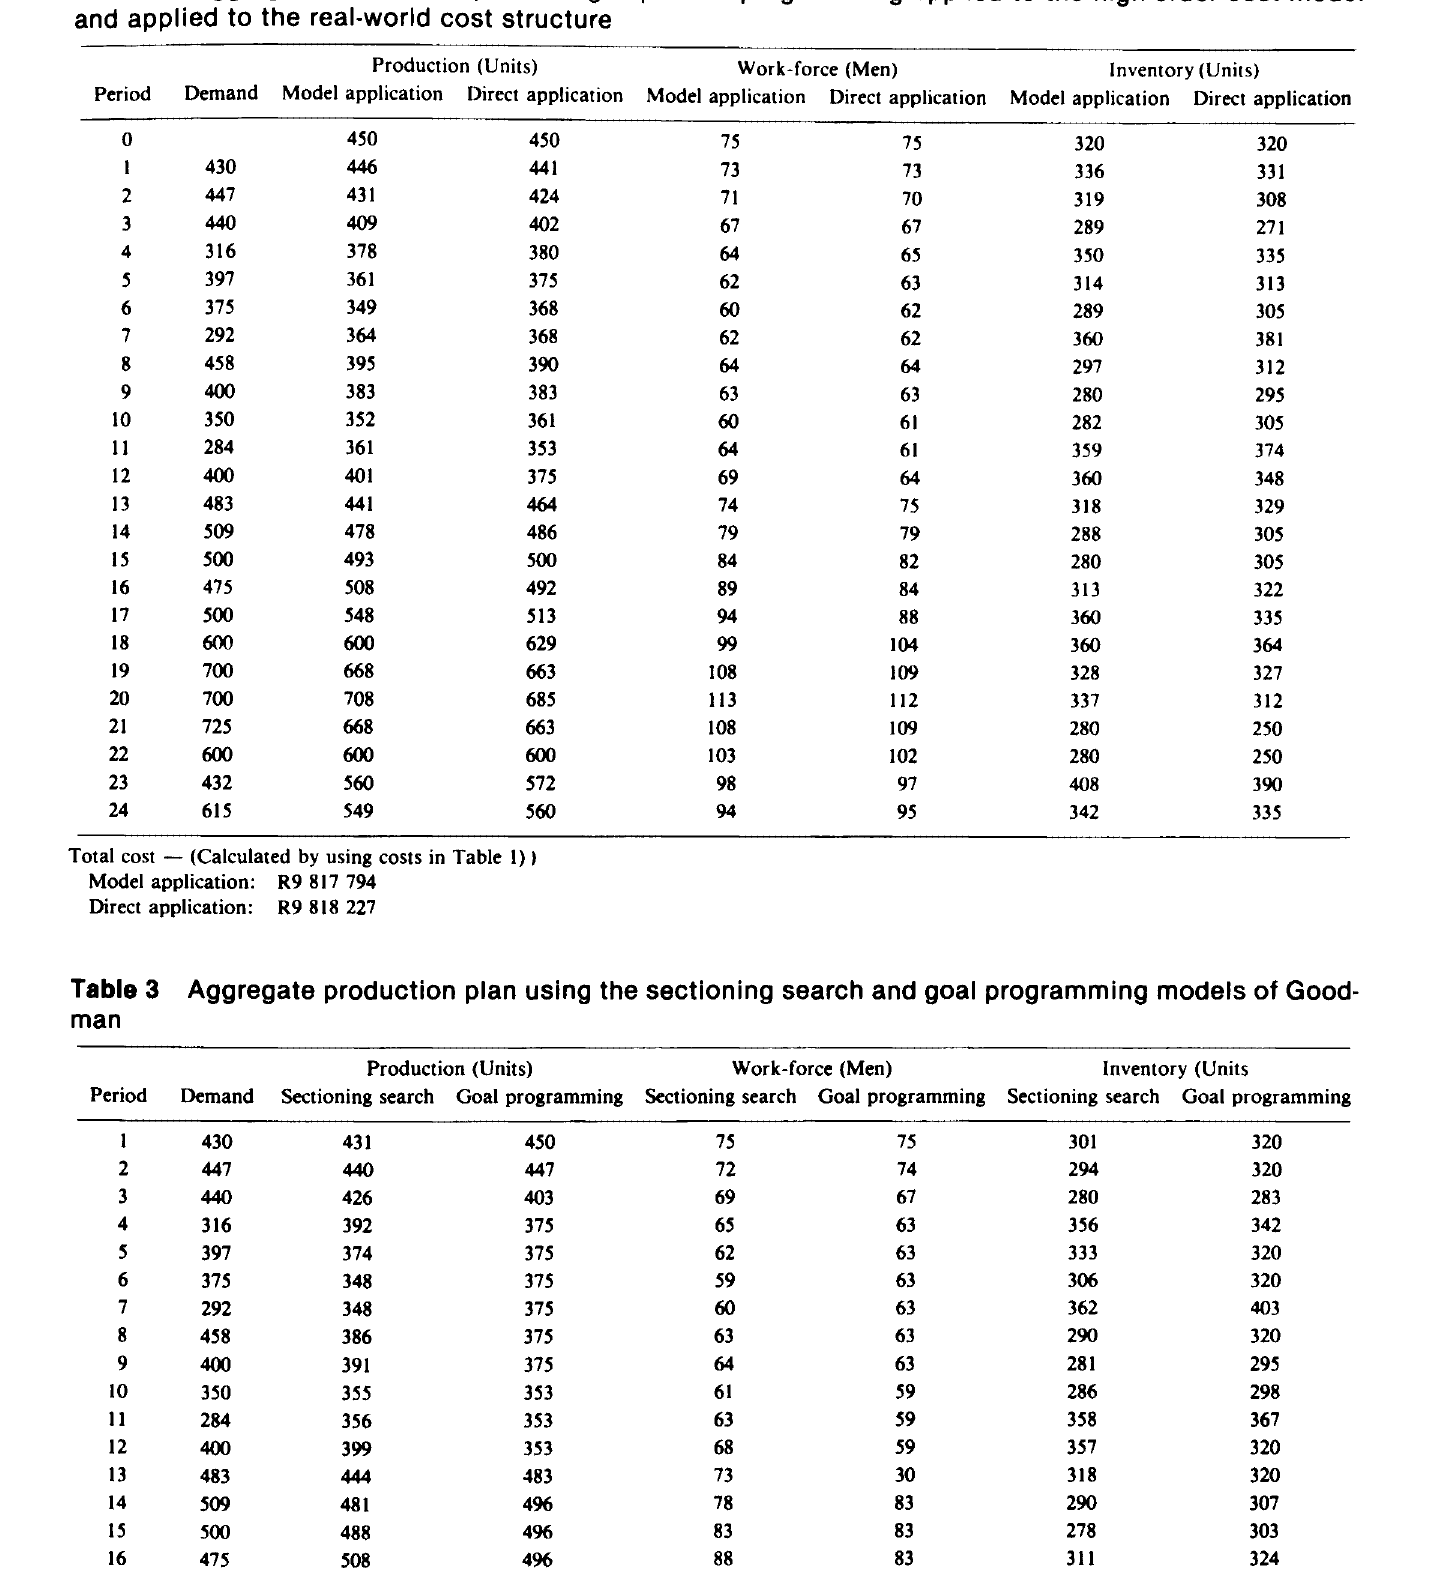
Table 2 Aggregate production plan using separable programming applied to the high-order cost model and applied to the real-world cost structure Production (Units) Work-force (Men) Inventory (Units) Period